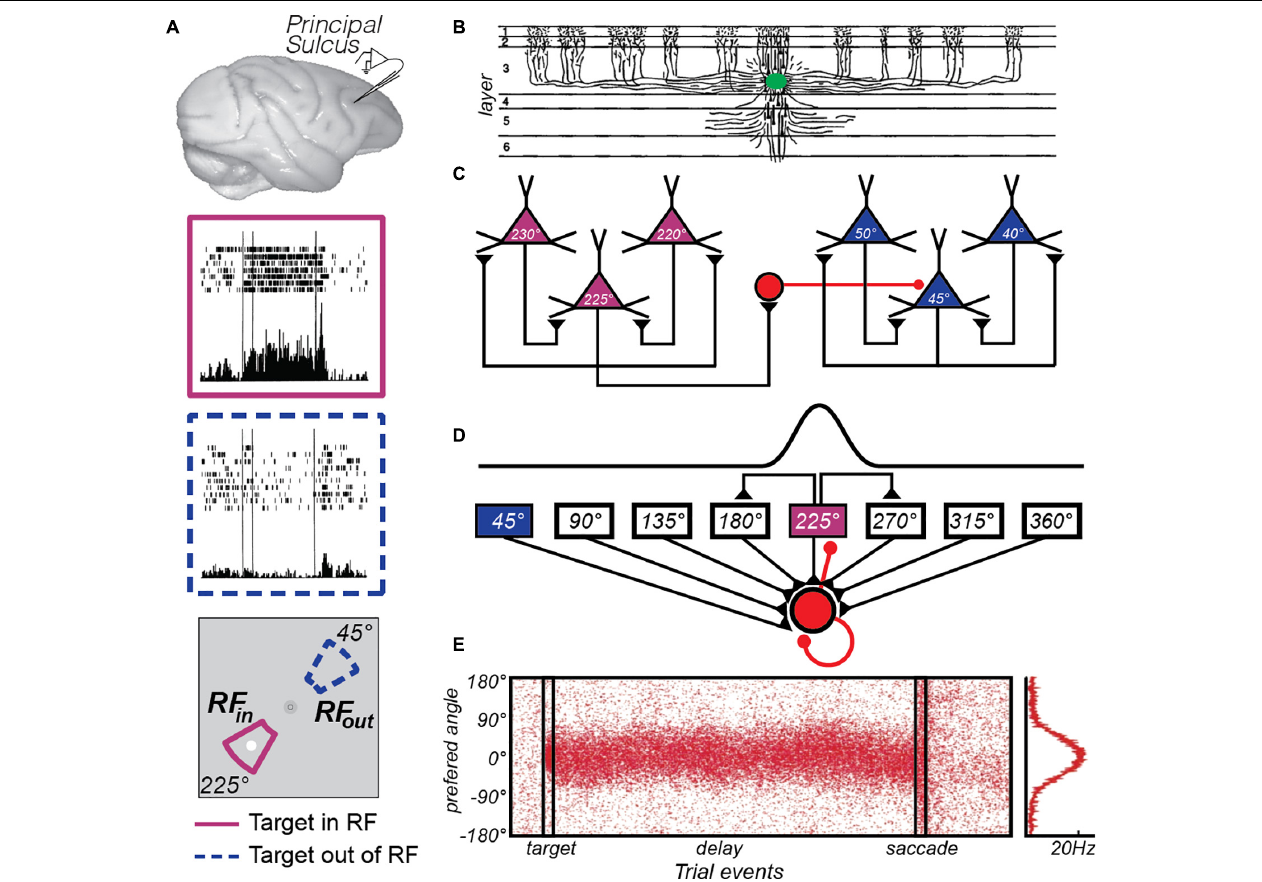
FIGURE 1 | The canonical PFC microcircuit model of WM. (A) Neural activity recorded from the principal sulcus in the macaque dorsolateral PFC. Activity persists during the delay period of memory-guided saccade tasks. The two insets depict a PFC neuron’s response when the memory target appears in and outside of it’s receptive or “memory” field. Adapted from data from Figure 3 of Funahashi et al. (1989). (B) Tracers injected into deep Layer III of the macaque PFC (green blob) revealed the extensive lateral connections of pyramidal cells (Levitt et al., 1993). (C) Goldman-Rakic (1995) hypothesized that these connections reflected similarly tuned pyramidal neurons, whose reciprocal excitatory and inhibitory connections enabled persistent activity. For instance, when remembering a target at 225 ◦ polar angle, recurrent excitation among similarly turned pyramidal neurons (purple triangles) maintains the location in WM through persistent activity. Inhibitory interneurons (red circle) suppress activity in neurons tuned to far away locations (blue triangles). Adapted from Wang et al. (2013). (D) This hypothesis was formulated into a computational theory in which both recurrent excitatory and inhibitory interactions were modeled (Wang, 2001). (E) This model produces location-specific persistent activity similar to that observed in recordings of neurons in macaque PFC. Each red dot is a synthetic “spike” in a population of neurons with different location preferences, where the target is aligned at 0 ◦ . Location is encoded in the population response and decoding involves a read-out of the peak at any given time point, curve at right. Adapted from Compte et al.